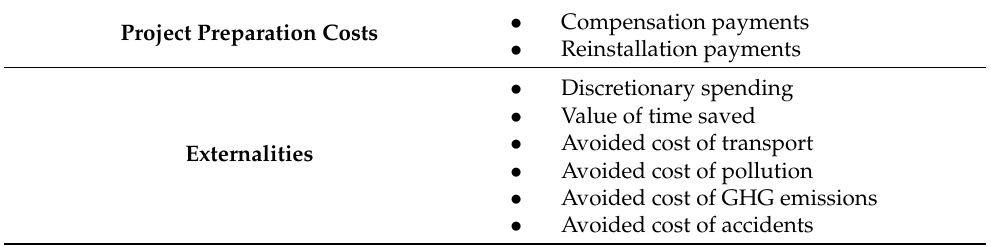
Table 4. Externalities and project preparation for the SAVi assessment of BRT in Dakar [75]. Project Preparation